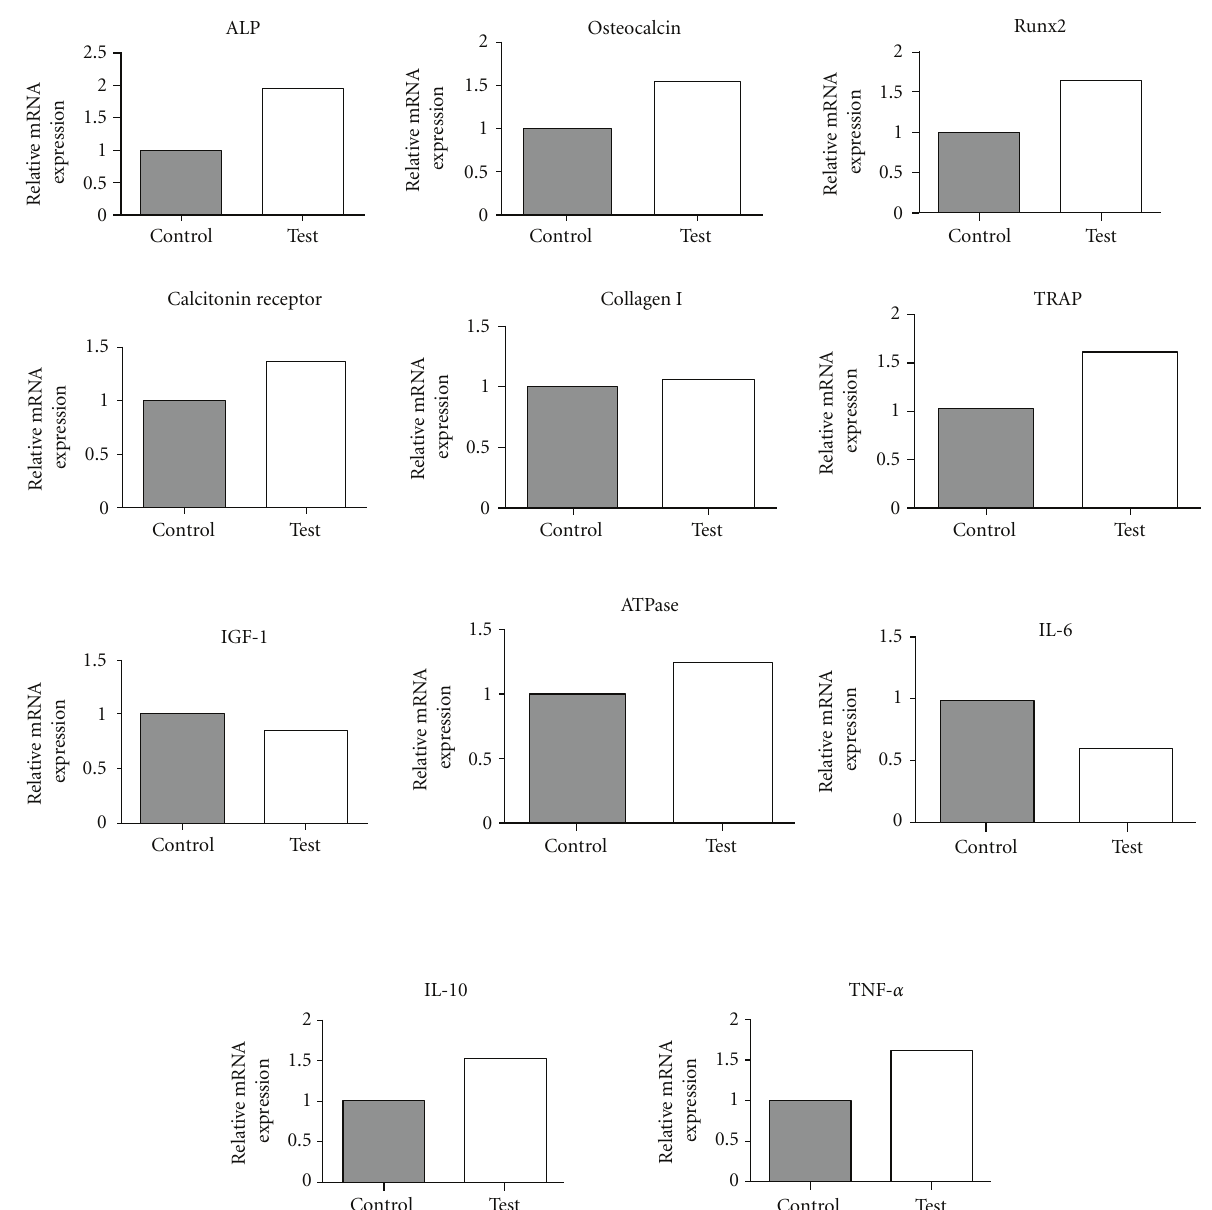
Figure 3: Gene expressions of bone formation markers by real-time RT-PCR for the non-laminin-1-coated (control) and -coated (test) groups. After 2 weeks, the surrounding tissues of implants were collected and total RNA of pooled samples was isolated. The osteogenic markers (ALP, osteocalcin, Runx2, calcitonin receptor, collagen I, TRAP, IGF-1, and ATPase) and inflammation markers (IL-6, IL-10, and TNF- α ) were evaluated and higher values were detected for the experimental group. The relative expressions of target genes were normalized with housekeeping gene β